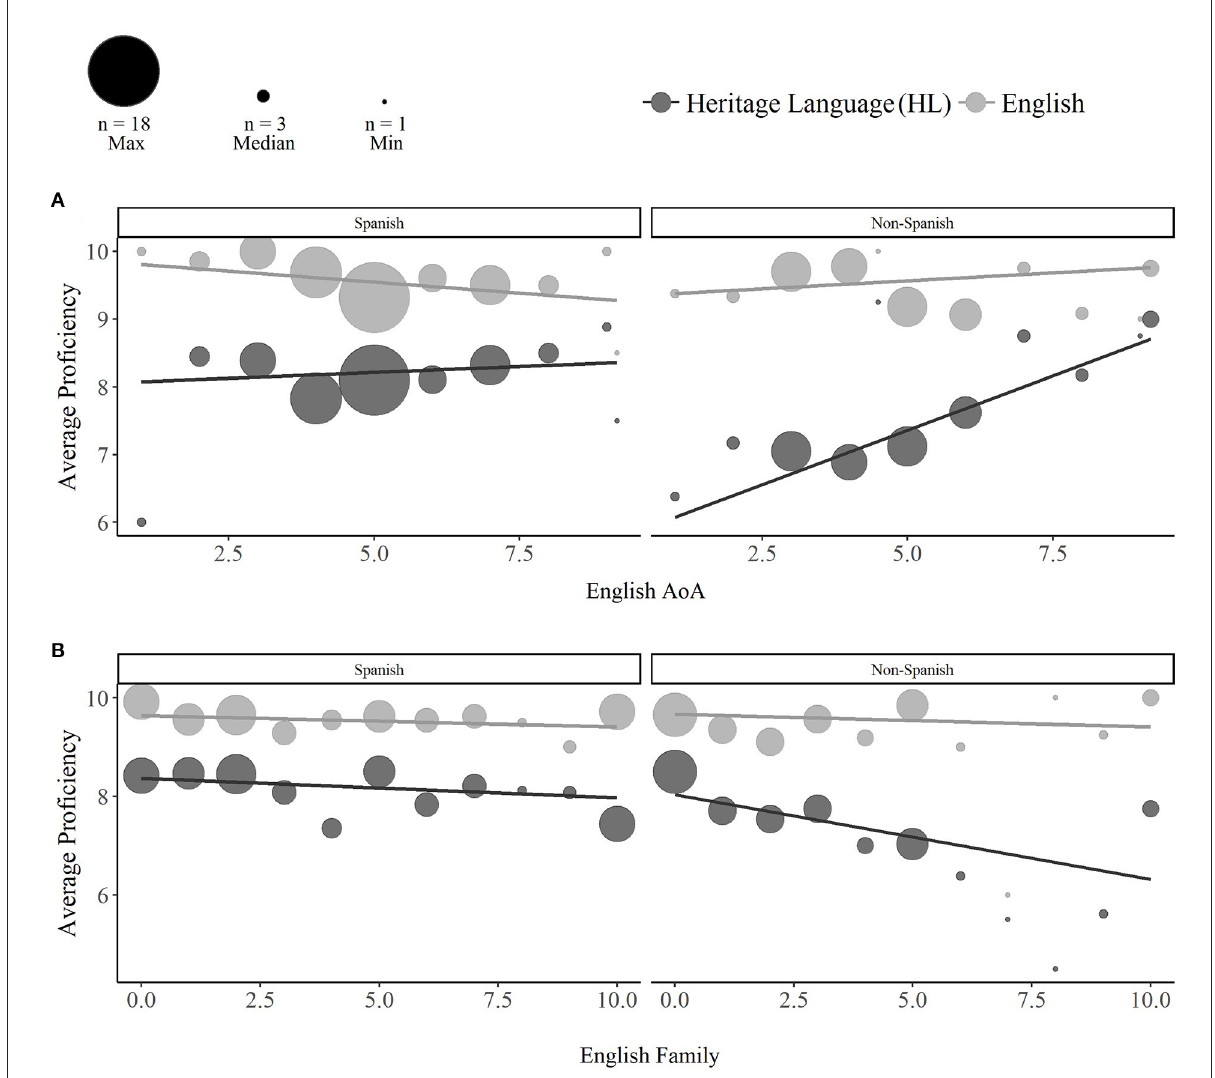
FIGURE2 Effects of English experience on self-reported HL (dark gray) and English (light gray) proficiency. Among non-Spanish bilinguals, HL proficiency increased with later ages of English acquisition (A) and decreased with greater English acquisition and exposure through family (B) . Dot sizes reflect the number of participants contributing to each aggregated value (max = 18, median = 3, min =